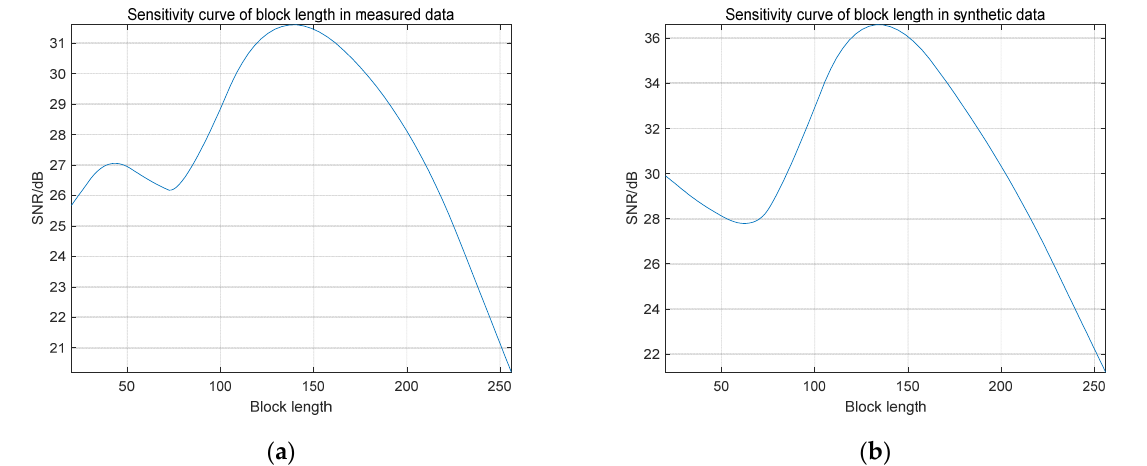
μ in measured data. th